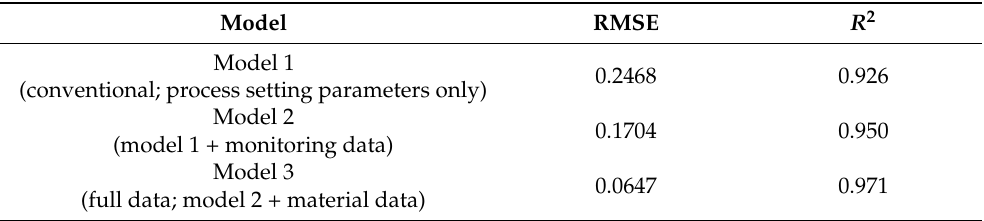
Table 6. Loss and R 2 values after training completion of each